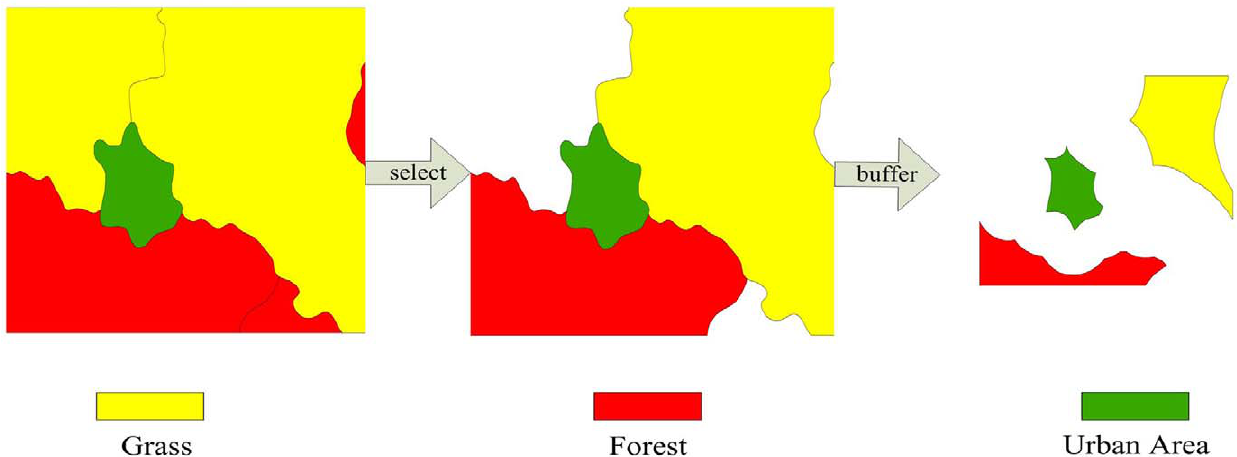
Figure 2. Sketch map of automatic collection of training samples.